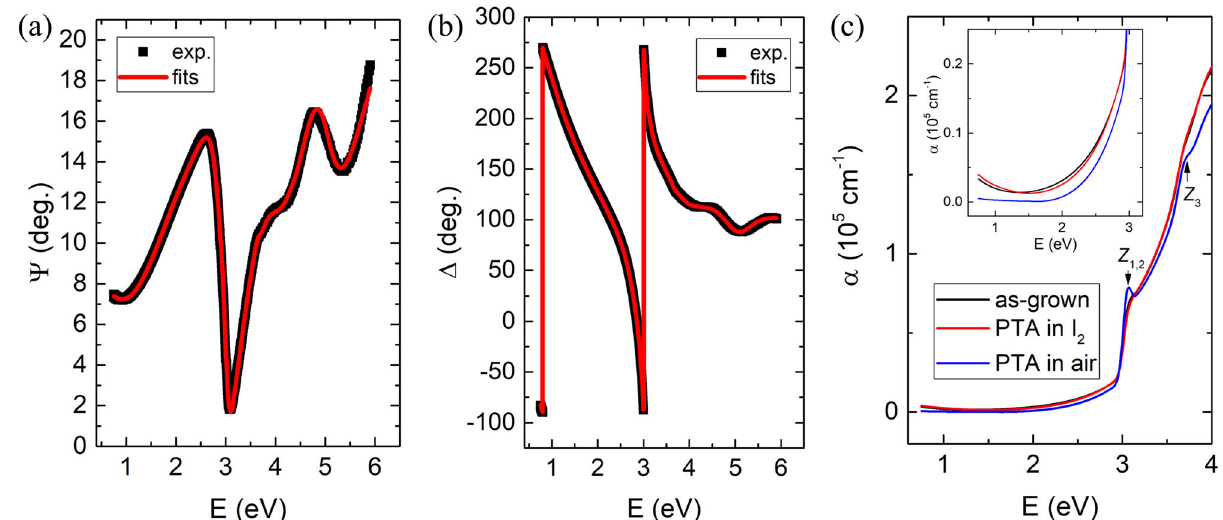
Fig. 2 | SE spectra and the derived absorption coef fi cient. The measured (black square)and the fi tted(red line) SE spectra( Ψ and Δ in a and b , respectively) of the